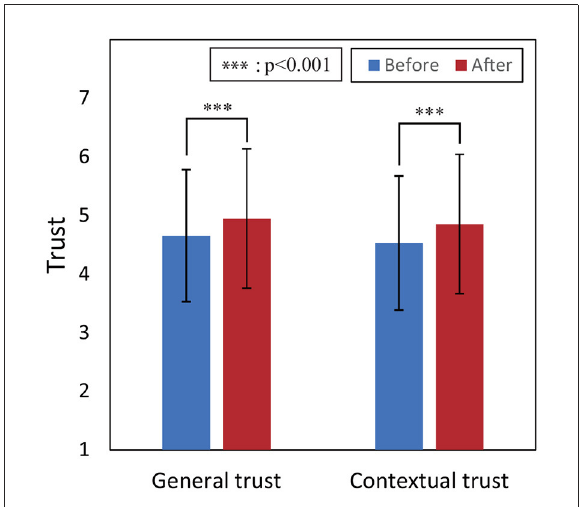
FIGURE4 Results of comparison between mean of each trust value before and after watching observed task. Error bars represent standard